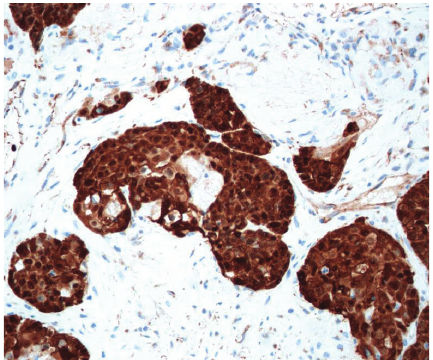
Figure 6: Positivity for beta-catenin is seen in both cytoplasm and nuclei of the neoplastic cells, except of dead shadow cells (SABC technique).